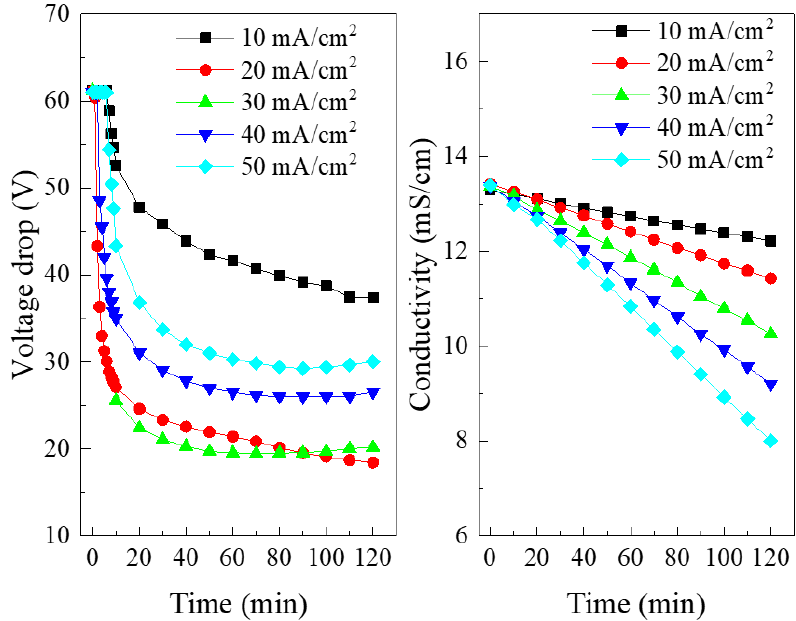
Figure3. E ff ectofthecurrentdensityonthevoltagedropacrosstheSEDBMstackandontheconductivity in the salt Figure 3. Effect of the current density on the voltage drop across the SEDBM stack and on the conductivity in the salt compartment.